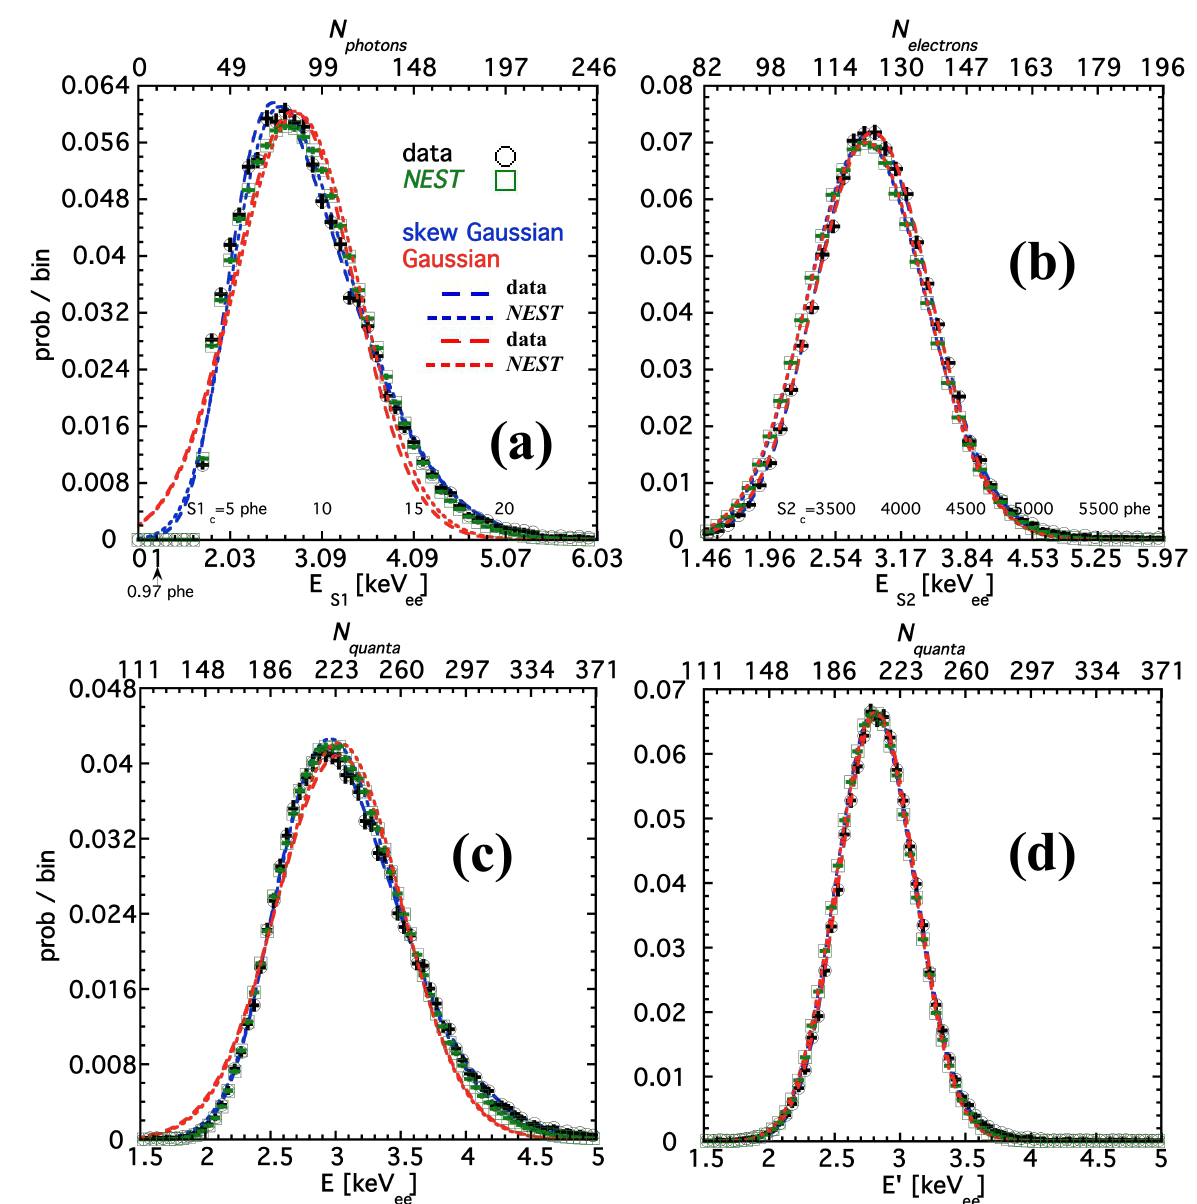
Figure 1. Reconstruction of the 2.8224 keV 37 Ar peak in the PIXeY detector [59] compared to the Noble Element Simulation Technique (NEST). Real data are always hollow black circles, NEST Monte Carlo (MC) data are green squares. Gaussian fits are in red, skew Gaussian (better fit) in blue, with the fits to data in long dash and NEST in short dash (indistinguishable due to NEST’s fidelity). Number of events in data 7.4 × 10 4 , while 9.3 × 10 5 in the MC, after all cuts (i.e., all thresholds). ( a ) Original, non-linear S1-only E scale used for liquid xenon (LXe). Bins with non-zero counts begin very suddenly at the left in both NEST and data due to a cut-off created by triggering only on 3-fold PMT (Photo-Multiplier Tube) coincidence, and other threshold requirements. The results are highly skewed, driving the asymmetry within the combined-energy fit later. ( b ) S2-only, which is quite symmetric, so that Gaussian and skew-Gaussian fits overlap. ( c ) The combined-energy scale in common use now for LXe dark matter (DM) detectors. Gaussian fits in red are clearly poorer compared to skew fits, diverging from the histogram in the cases of NEST and data alike. ( d ) An optimized combination for energy, as done on PIXeY. Both NEST and data, and Gaussian and skew-Gaussian fits alike, have all become indistinguishable for this stage. The best-fit mean energy has shifted from 3.03 keV in ( c ) to 2.82 keV for ( d ). This improvement in precision is also reflected in the sum of the mean quanta from ( a , b ) matching ( d ), but not ( c ), which is too high. The skew parameter α decreases from 3 for S1 only ( a ) to 2 for the combined scale in ( c ) and 1 in ( b , d